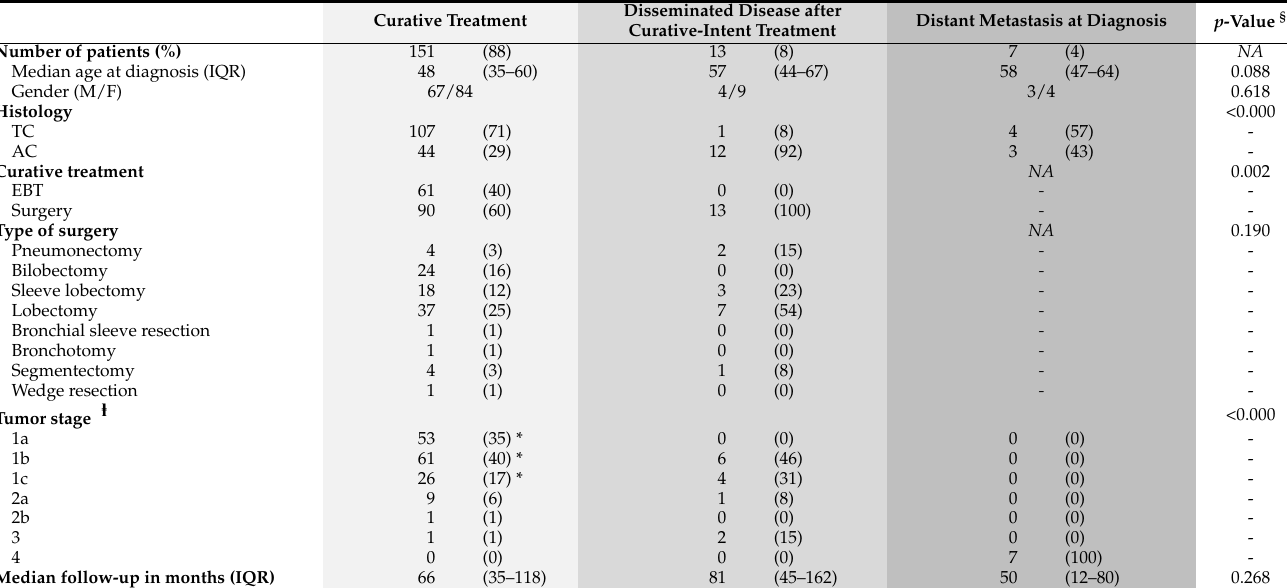
Table 1. Clinicopathological characteristics of patients treated for bronchial carcinoid ( n = 171).